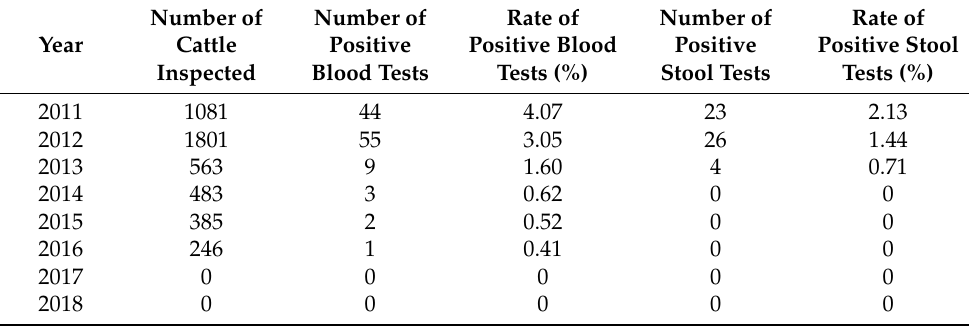
Table 2. Infection of schistosomiasis among farm cattle in Wetland Park.